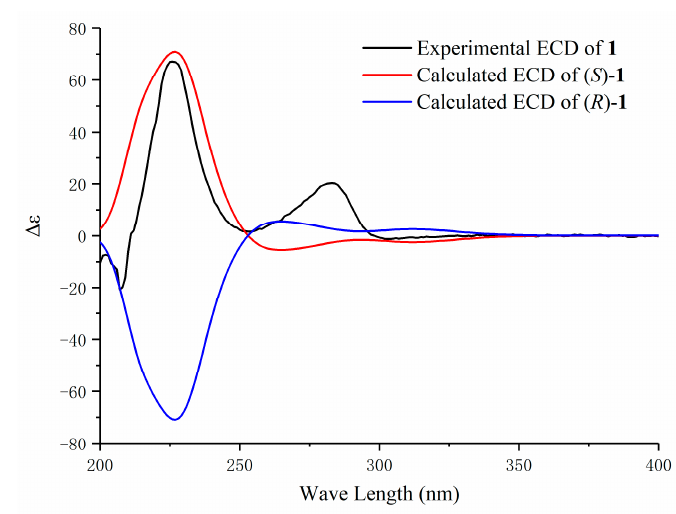
Figure 2. Experimental and calculated electronic circular dichroism (ECD) spectra of compound 1.